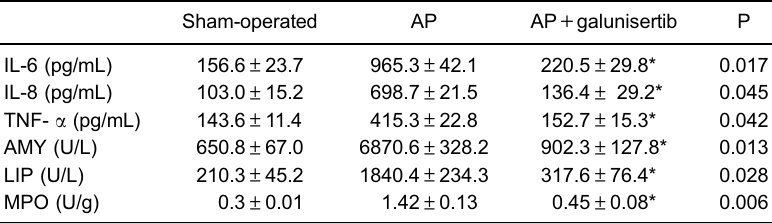
Table 1. IL-1 b , IL-6, TNF- a , amylase (AMY), lipase (LIP) and tissue myeloperoxidase (MPO) activity in pancreatic tissue of sham-operated, acute pancreatitis (AP)-induced, and AP + galunisertib treated